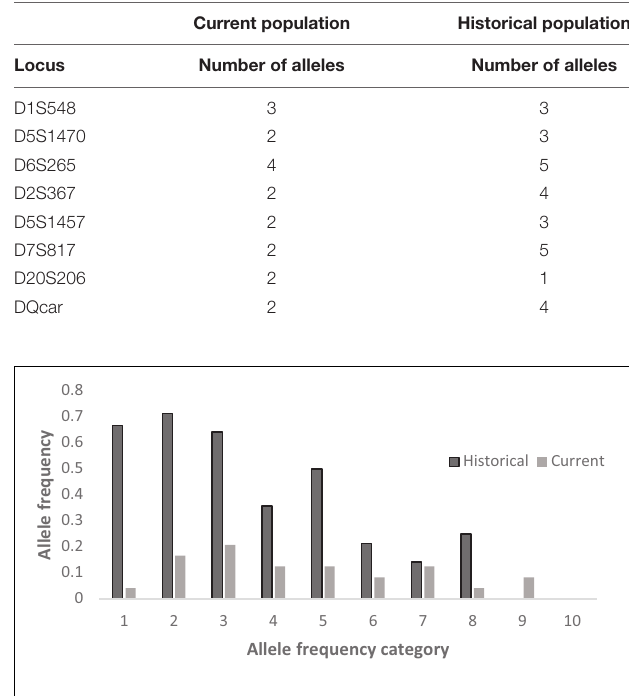
FIGURE 6 | Distribution of allele frequencies for the historical and current populations across 8